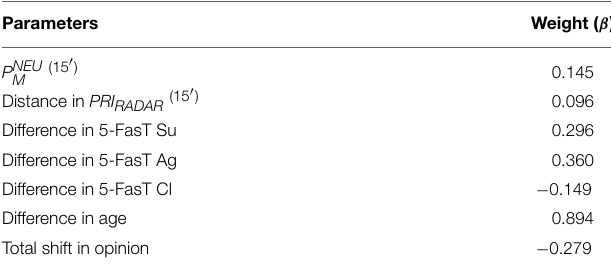
TABLE 5 | Discriminant function parameters: model of incoherent dyads. Parameters